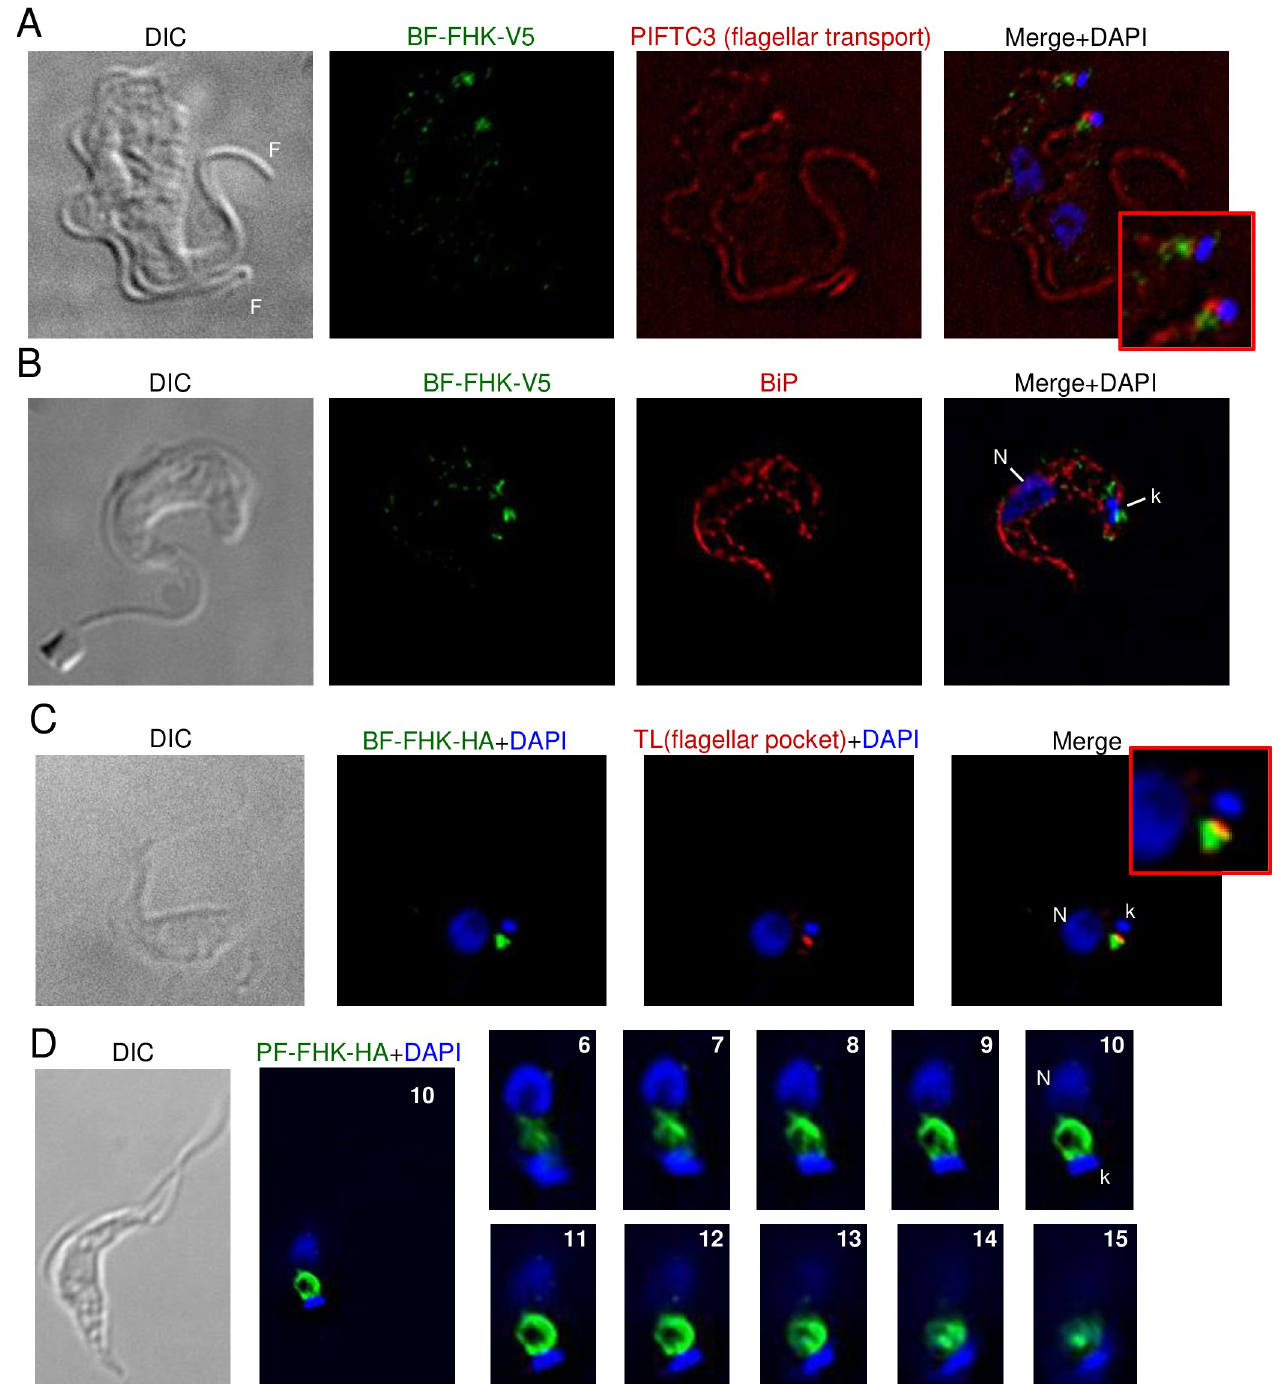
Fig 8. Predominant localization of epitope-tagged FHK near the kinetoplast. A, B) BF expressing FHK-V5 and co-stained with DAPI, anti-V5 antibodies, and either anti-PIFTC3 (A) or anti-BiP (B). Enlargement shows region around kDNA. The cell in (A) has duplicated both its nucleus (N) and kDNA (k) and is undergoing cytokinesis as evidenced by the presence of two flagella (F). The cell in panel B has an elongated, slightly V-shaped kinetoplast, indicating it is undergoing kinetoplast division and is in nuclear S phase. Note that a point of FHK-staining occurs at either pole of the elongated kDNA. C) PF expressing FHK-HA were incubated with biotinylated-tomato lectin (TL) at 4 o and fixed prior to staining with DAPI, avidin and anti-HA. Enlargement shows region around kDNA. D) Whole cell and enlarged serial planes (numbered) of a DAPI-stained PF cell expressing FHK-HA. All images (except enlargements) are at the same magnification. Bar = 5 μ